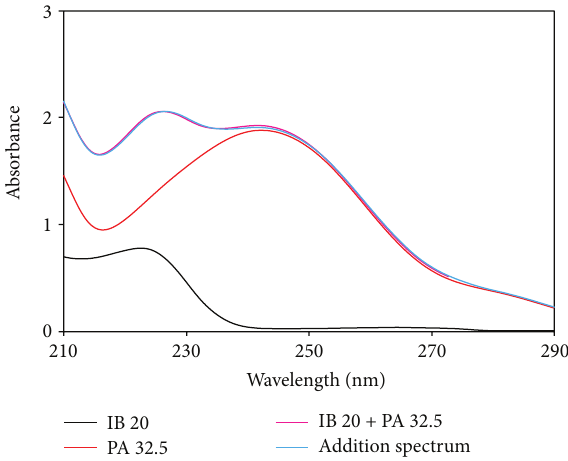
Figure 3: Spectra of IB 20 mg/L, PA 32.5 mg/L, and their corre- sponding mixture and absorbance